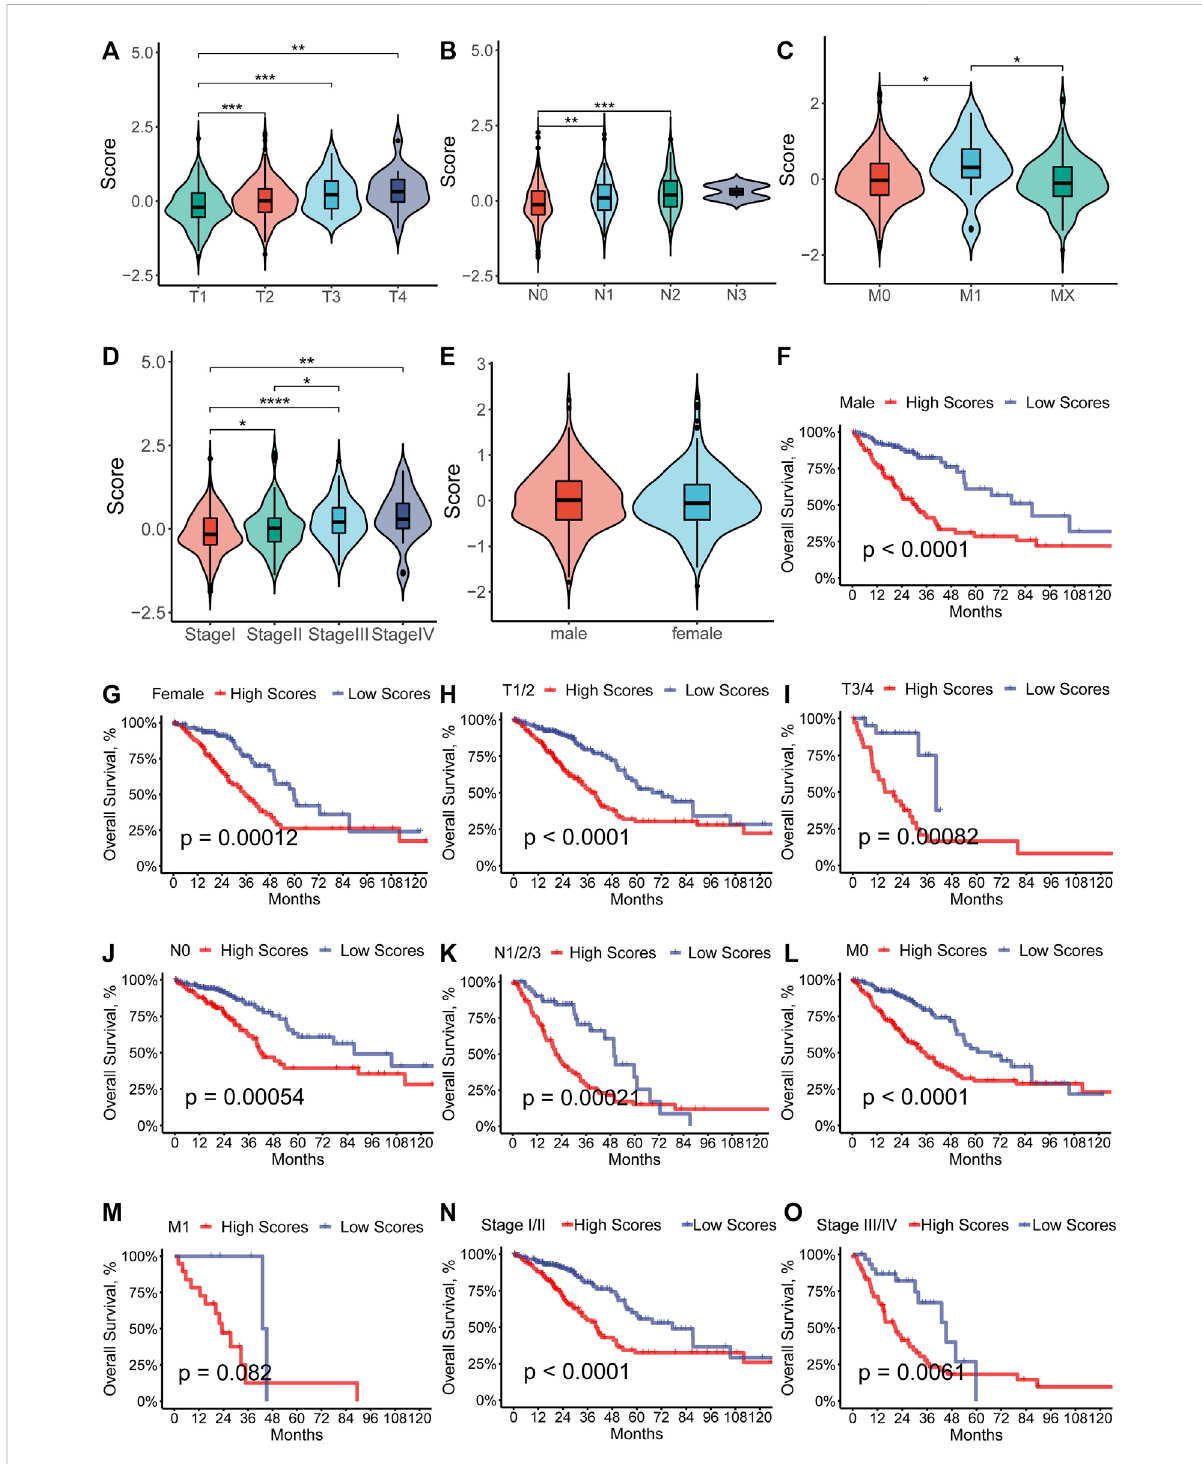
FIGURE 4 (A – E) Distribution of the RS separated by the clinical-pathological features among the LUAD patients in the TCGA cohort. (F – O) Subgroup analysis of prognostic value of the ferroptosis-prognostic model for LUAD patients by Kaplan – Meier curves according to clinicopathologic